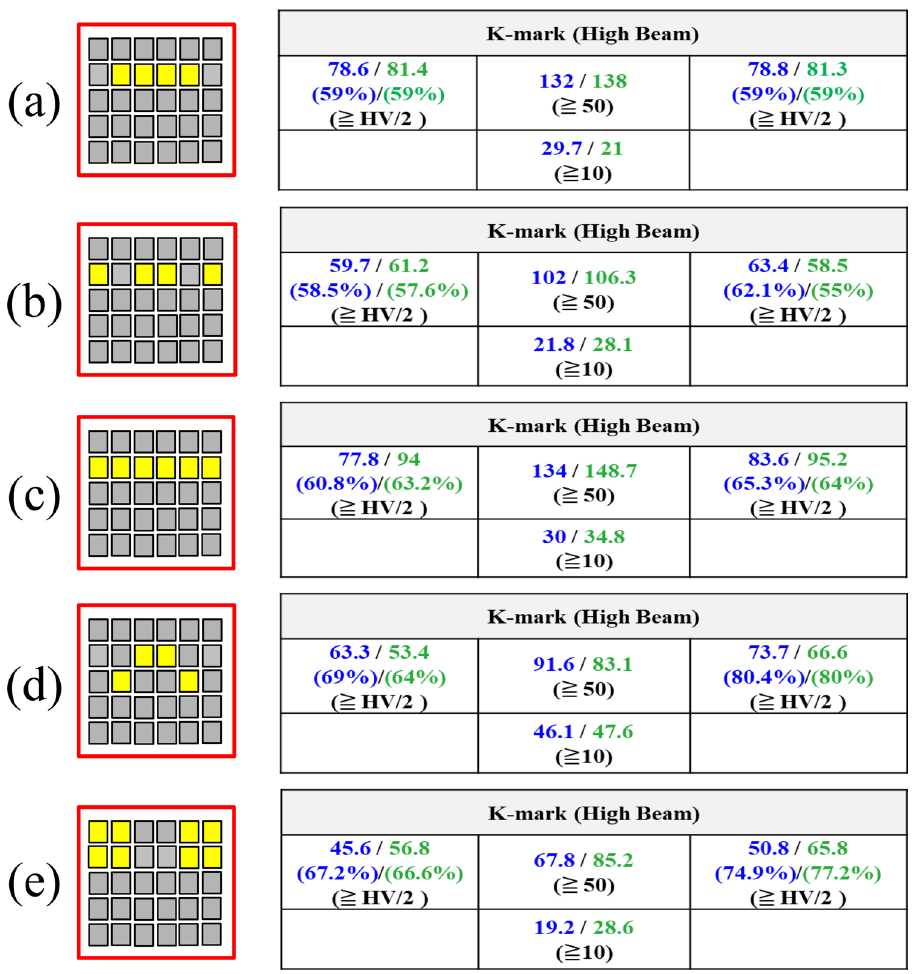
Figure 10. The check points for the high beam of the K mark regulation when ( a ) B2/C2/D2/E2 ( b ) A2/C2/D2/ F2 ( c ) A2/B2/C2/D2/E2/F2 ( d ) B3/C2/D2/E3 ( e ) A1/B1/E1/F1 and A2/B2/E2/F2 were turned on. The first value in blue is from the simulation, and second value in green is by measurement.